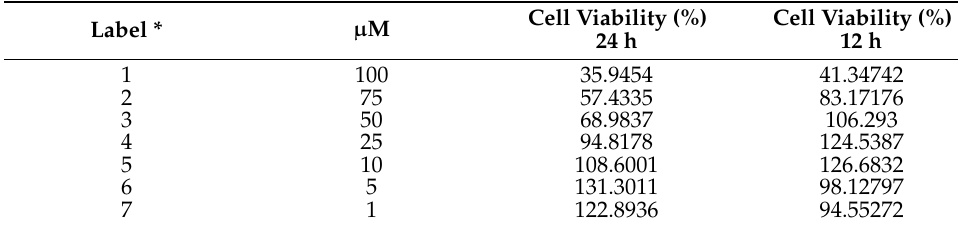
Figure 6. Results of dose- and time-dependent cytotoxicity experiments conducted on HaCaT cells. * p < 0.05 with respect to Ctr cells, # p < 0.05 between determinations. Table 5. Cell concentration and viability data (%).